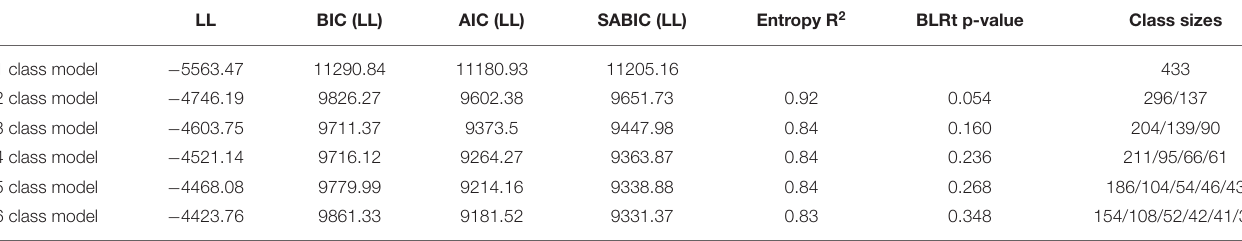
Table 3 ). See Supplementary Table 2 for estimates